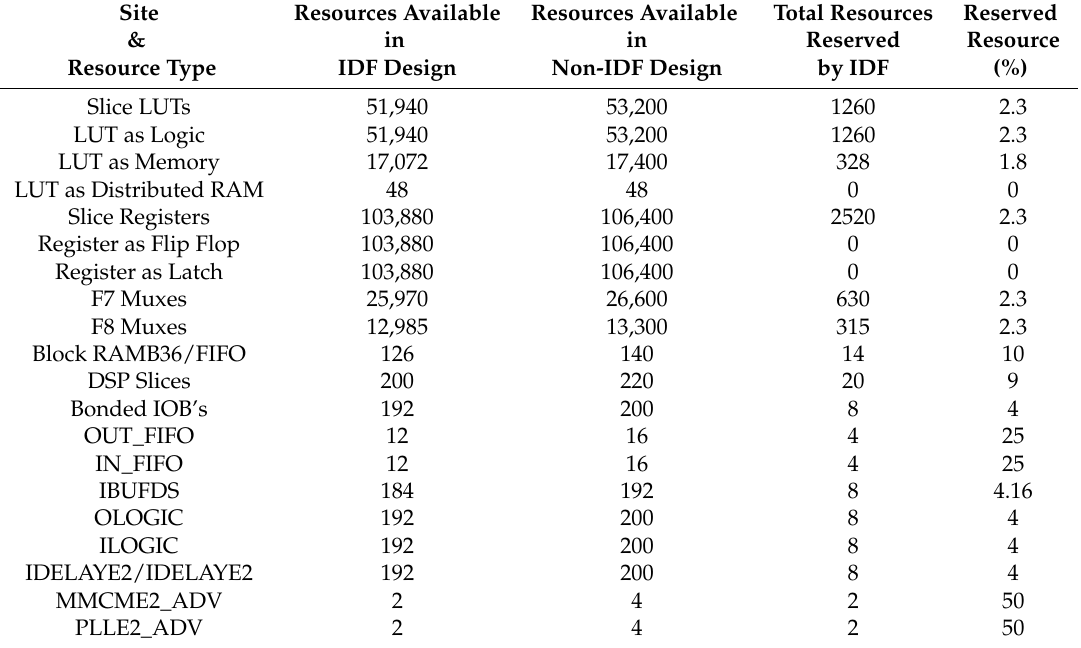
Table 3. IDF Resource Utilization Overview.